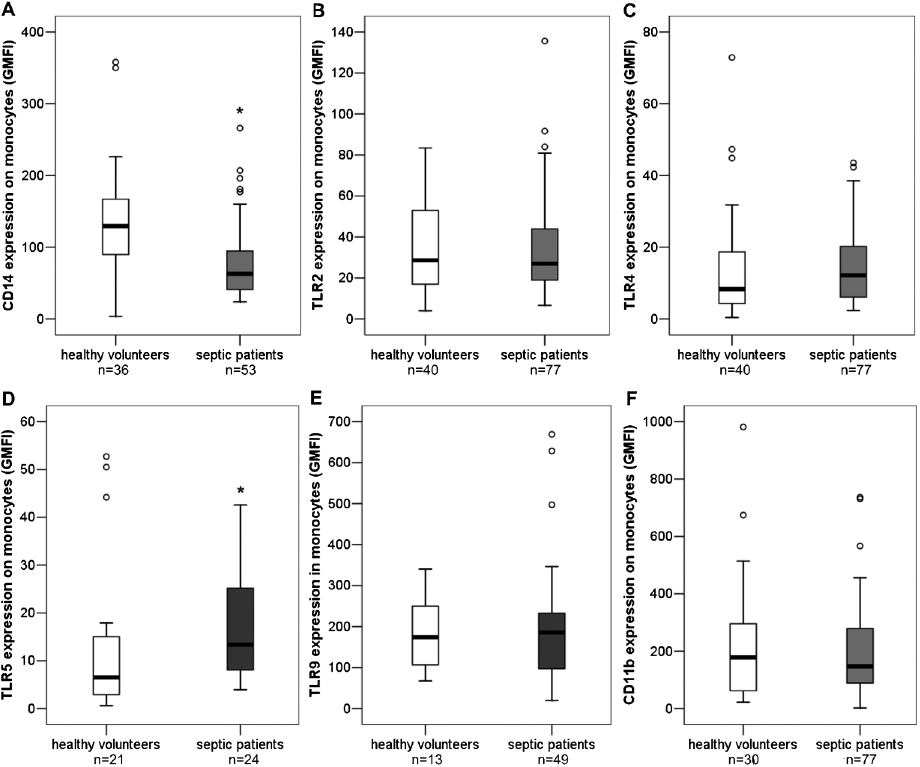
Figure 1. Analysis of the expression of surface and intracellular receptors on monocytes from healthy volunteers and septic patients. Receptor expression was analyzed in histograms and reported as the geometric mean fluorescence intensity (GMFI): CD14 ( A ), TLR2 ( B ), TLR4 ( C ), TLR5 ( D ), TLR9 ( E ), and CD11b ( F ). Data are reported as box plots, medians with 25 to 75% quartiles (box) and mini- mum and maximum values (bars). Empty circles indicate outliers. *P , 0.05 compared to healthy volunteers (Mann-Whitney